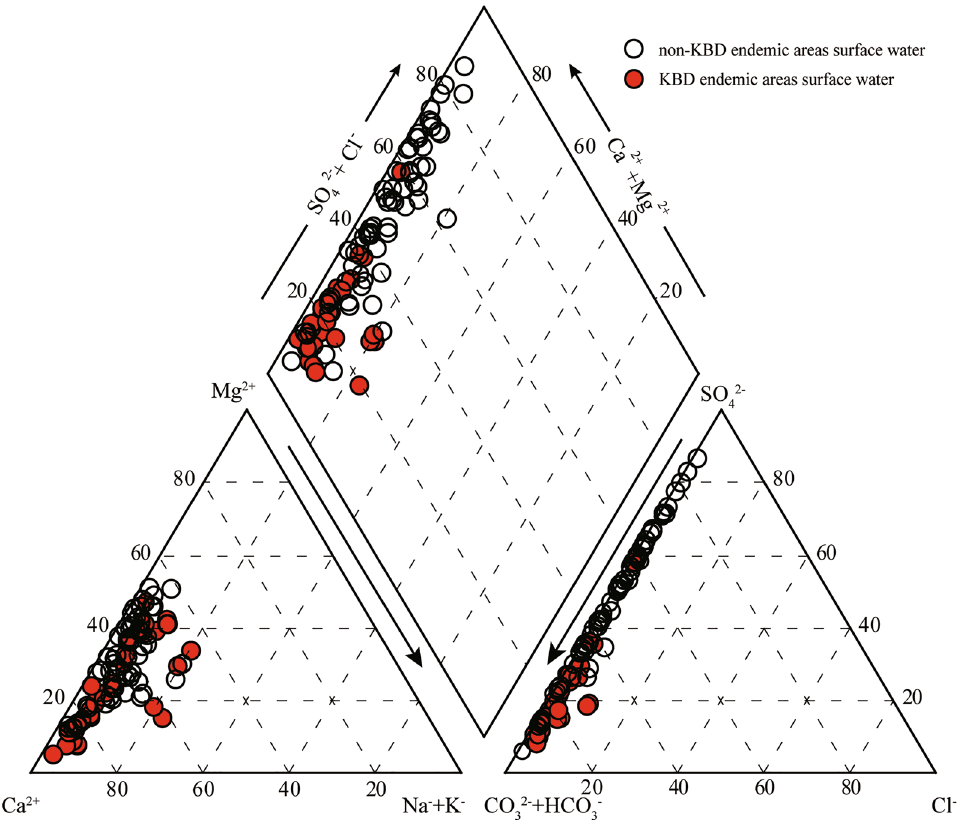
Figure 2. Piper diagram 5 showing the characteristics of surface waters in the Longzi County.